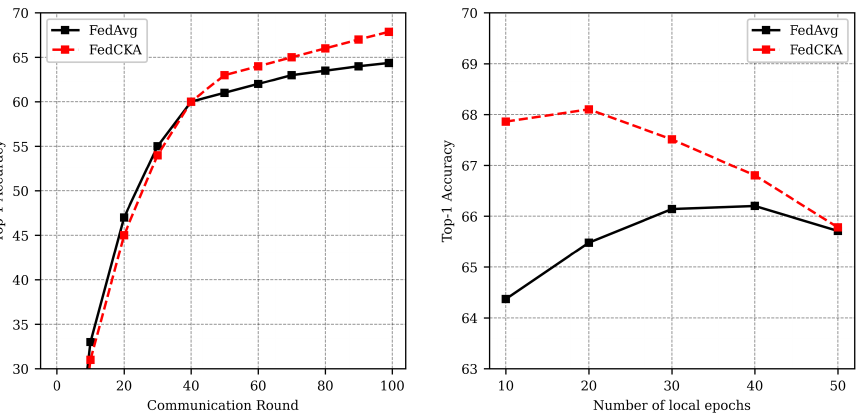
Figure 5. Effects of communication round and local epochs.